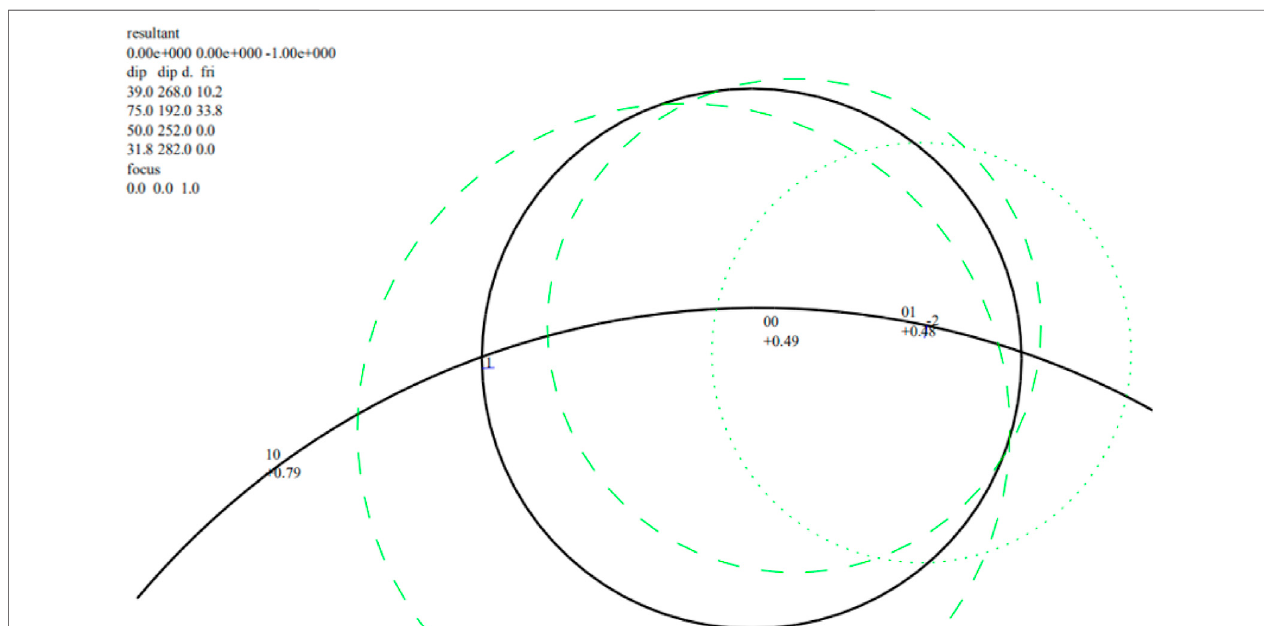
FIGURE 7 | Stereographic projection of the strata and NWW near section 1.